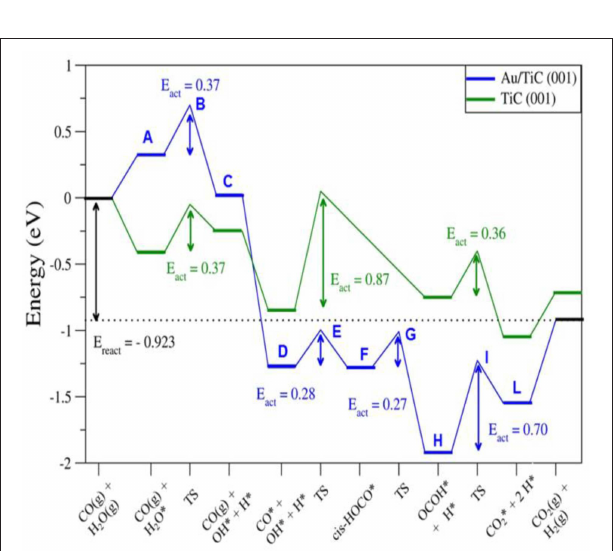
Frontiers in Chemistry |